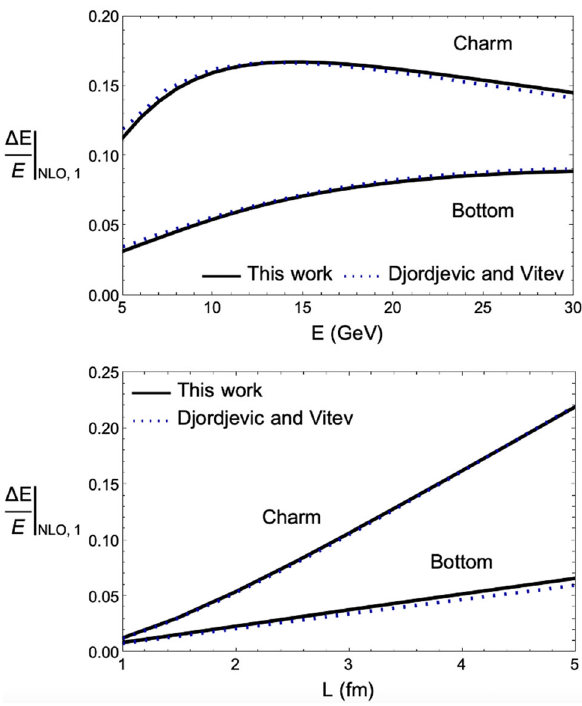
Fig. 7 The first order in opacity fractional energy loss for charm and bottom quarks given by (14) is plotted as a function of parent parton energy (upper plot) and the effective static thickness L (lower plot) of a plasma characterised by α s = 0 . 3, μ = 0 . 5 GeV and λ = 1 fm. The black solid curves show the implementation of this work, while the blue dashed curves are given by the results of Djordjevic and Gyulassy (see Figures 1 and 2 in [72]). For the upper plot we take L = 4 fm, while the lower plot takes E = 10 GeV. The charm and bottom quark masses are taken to be m c = 1 . 6 GeV and m b = 4 . 75 GeV